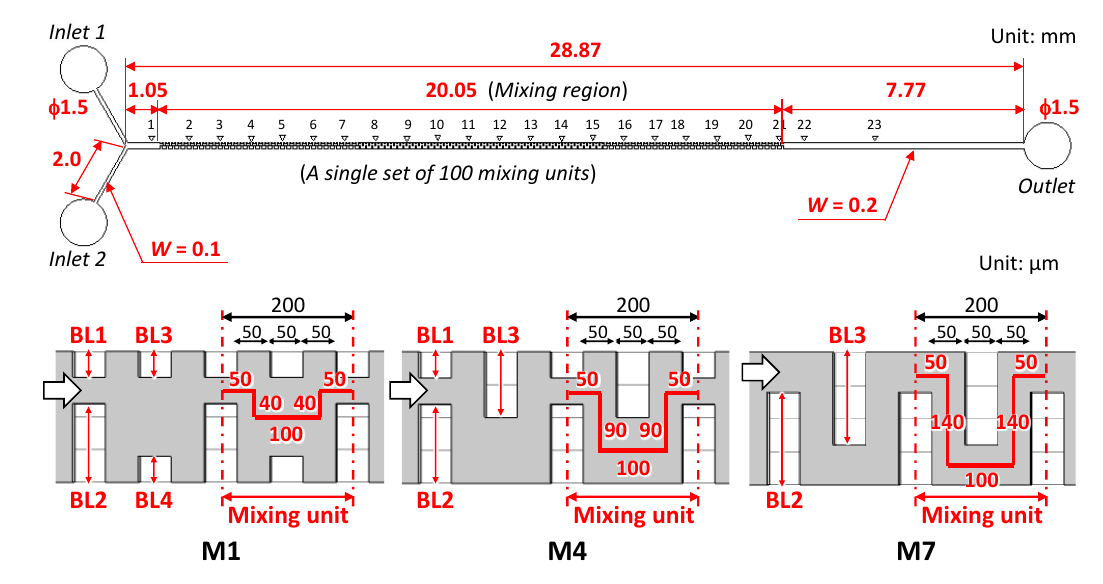
Figure 6. Detailed design of the asymmetric mixers consisting of a single set of 100 mixing units employed in the experiments to investigate the influence of the geometrical configurations and dimensions of the asymmetric mixers on the mixing efficiency. Table 2. Geometric dimensions of the obstacle structures of six different types of mixing units inte- grated into the asymmetric micromixers (M1–M6) and a serpentine micromixer (M7) with a sym- metric mixing unit (Figure 6).